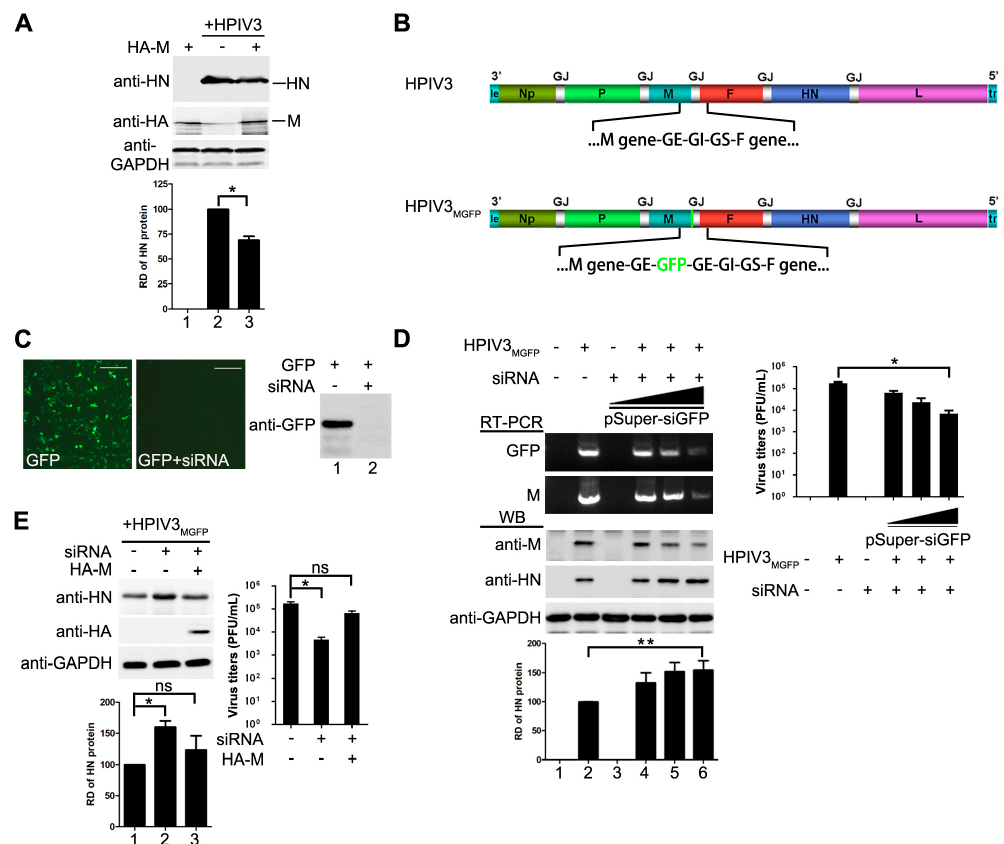
Figure 2. M reduces HPIV3 replication. ( A ) over-expression of M reduces the replication of HPIV3. HeLa cells were transfected with vector or plasmids encoding M (2 µ g). At 24 hpt, the cells were infected with HPIV3. At 48 hpt, the cells were harvested and lysed for Western blot. Quantity one software was used to quantify the band intensities of HN in the lysates. Values are means ± standard deviations (SD) from three independent experiments. Student’s t test: * p < 0.05; “+, − ” means with or without transfecting M plasmid. ( B ) genomic structure of HPIV3 GFP generated in this study. A GFP gene was inserted into the gene end of M and the recombinant virus was rescued as described in Materials and Methods; ( C ) validity test of pSuper-siGFP. Plasmid encoding GFP (50 ng) was transfected alone or together with 2 µ g of pSuper-siGFP in HeLa cells. At 24 hpt, the cells were subjected to fluorescence detection and Western blot assay; “+, − ” means with or without transfecting corresponding plasmids. Scale bar, 100 µ m. ( D ) knocking down of M slightly promotes the replication of HPIV3 and extensively reduces viral budding. HeLa cells were transfected with increasing amounts of pSuper-siGFP (0.5 µ g, 1 µ g, 2 µ g). At 24 hpt, the cells were infected with HPIV3 MGFP . At 48 hpi, half of the cells were collected for RNA extraction. RT-PCR was used to confirm the effect of siGFP on the transcription of M-GFP mRNA. The other half of cells was lysed for Western blot to detect the expression of M and HN. Supernatants were harvested for titer determination. Quantity one software was used to quantify the band intensities of HN in the lysates. Values are means ± standard deviations (SD) from three independent experiments. Student’s t test: * p < 0.05, ** p < 0.01; “+” means positive transfected or infected corresponding plasmids or viruses. “ − ” means negative transfected or infected corresponding plasmids or viruses. ( E ) re-expression of M rescues viral titer and counteracts effect of pSuper-siGFP knockdown. HeLa cells were transfected with 2 µ g of pSuper-siGFP. At 24 hpt, the cells were infected with HPIV3 MGFP . At 24 hpi, HeLa cells were transfected with 1 µ g of pcDNA3.0 vector or pcDNA3.0-HA-M. At 48 hpi, cells were harvested and lysed for Western blot assay. Supernatants were harvested for titer determination. Quantity one software was used to quantify the band intensities of HN in the lysates. Values are means ± standard deviations (SD) from three independent experiments. Student’s t test: * p < 0.05, ns = not significant. “+, − ” means with or without transfecting corresponding